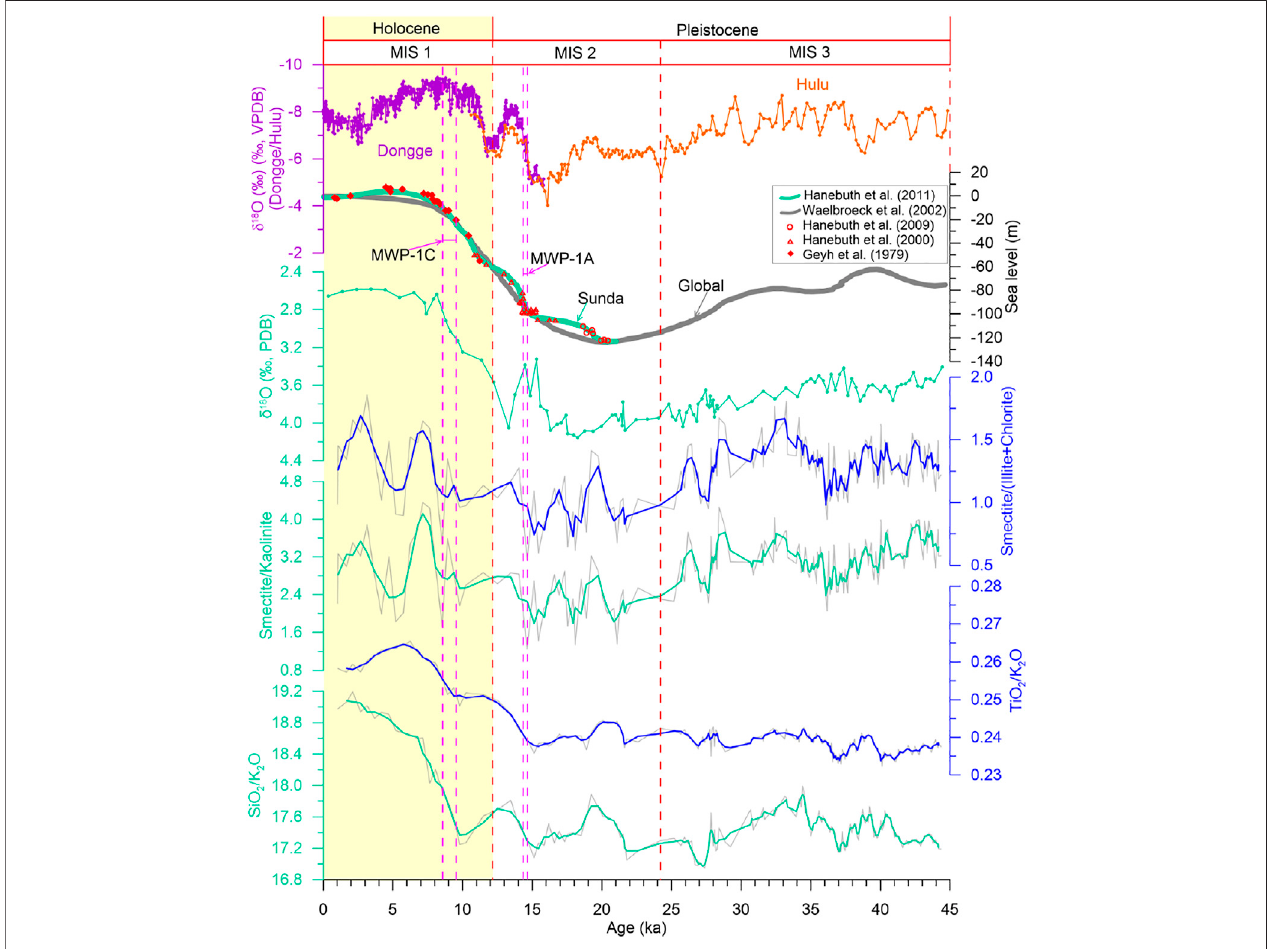
FIGURE 8 | Comparison of smectite/(illite + chlorite), smectite/kaolinite, SiO 2 /K 2 O, and TiO 2 /K 2 O ratios of Core MD05-2896, with benthic foraminiferal C. wuellerstor fi δ 18 O records at Core MD05-2896 (Wan et al., 2020) and stalagmite δ 18 O records of the Hulu and Dongge Caves (Wang et al., 2001; Dykoski et al., 2005). Sea-level data are from Geyh et al. (1979), Waelbroeck et al. (2002), and Hanebuth et al. (2000); Hanebuth et al. (2009); Hanebuth et al. (2011). Dashed magenta lines indicate the meltwater pulses 1A (MWP-1A) (Hanebuth et al., 2000) and 1C (MWP-1C) (Tjallingii et al., 2010).